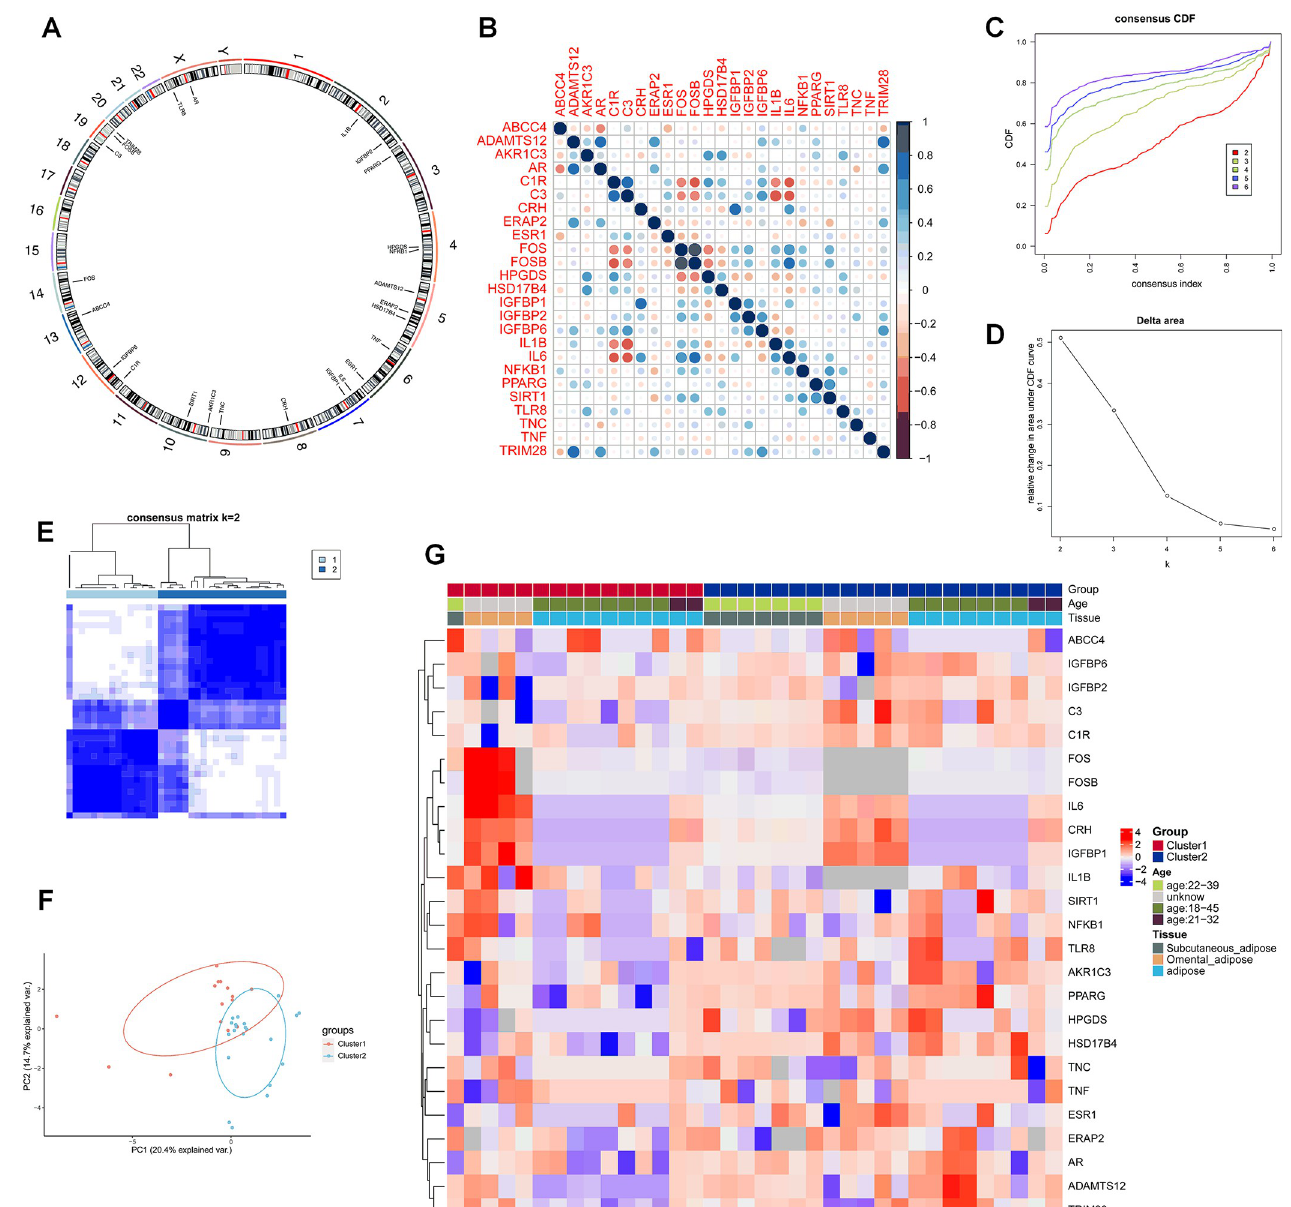
Fig 1. Identification of molecular subtypes in PCOS based on preterm labor or labor-related genes. (A) Chromosomal distribution diagram of preterm labor or labor-related genes involved in the present study. (B) The relationship among preterm labor or labor-related genes of interest were shown. (C) The cumulative distribution function (CDF) curves of consensus scores based on different subtype number (k = 2, 3, 4, 5, 6) and the corresponding color are represented. (D) The CDF Delta area curve of all samples when k = 2. (E) A relative stable partitioning of the samples at k = 2 in consensus heatmap. (F) In PCA analysis, the symbols represent the gene expressed differently in two clusters. (G) The expression heatmap of the preterm labor or labor-related genes among various molecular and clinical subtypes.